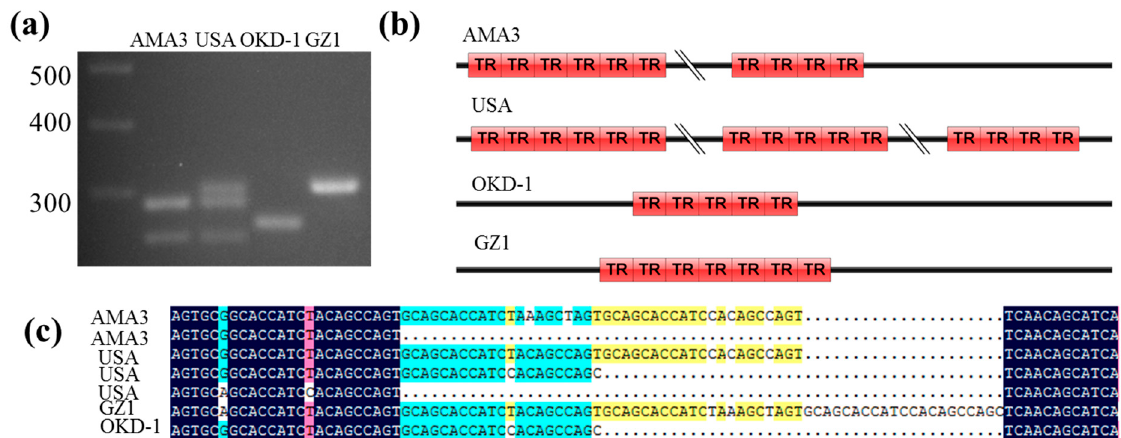
Figure 5. Copy number variations among different B. xylophilus strains. ( a ) PCR validation of copy number variations, ( b ) Illustrations of various TR combinations within different B. xylophilus strains and ( c ) Validation of various TR combinations within different B. xylophilus strains.